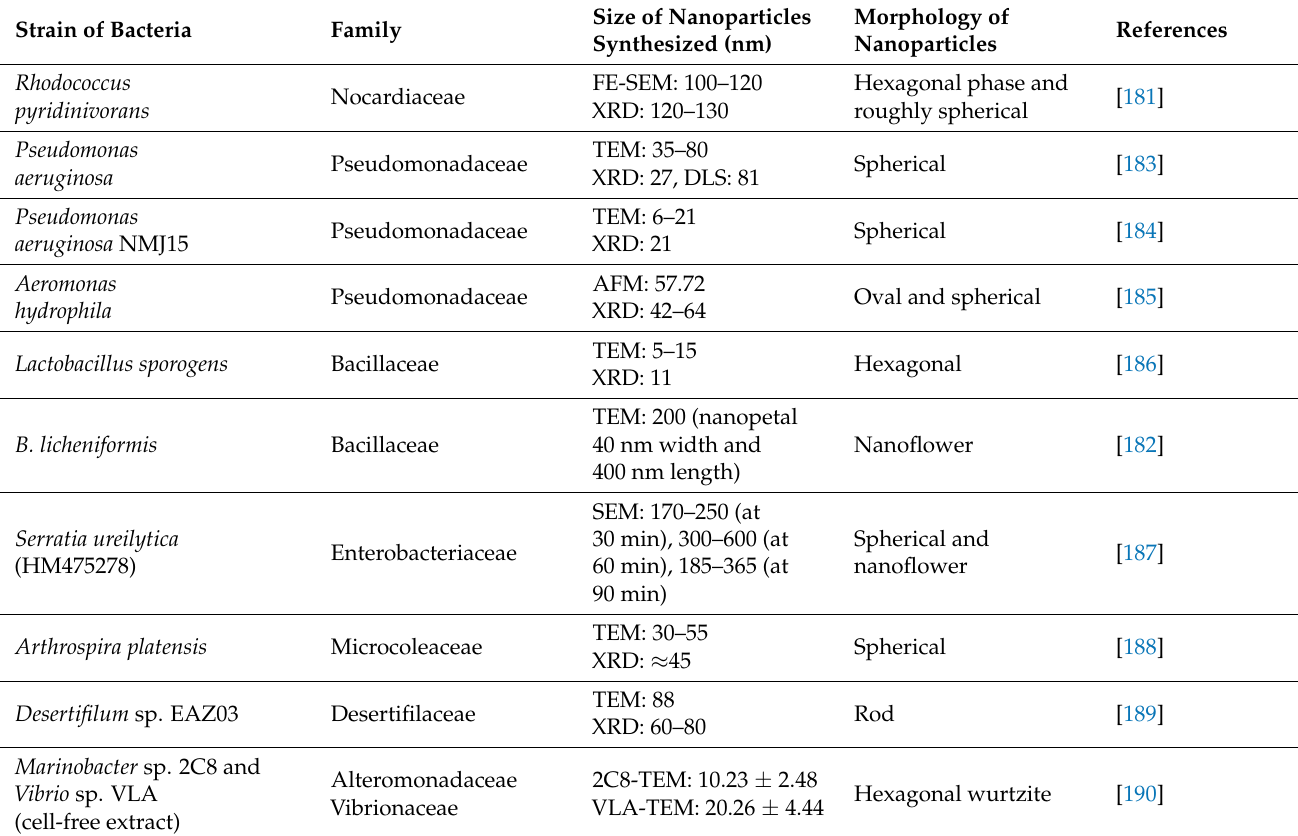
Table 2. Summary of the bacteria-mediated synthesis of zinc oxide